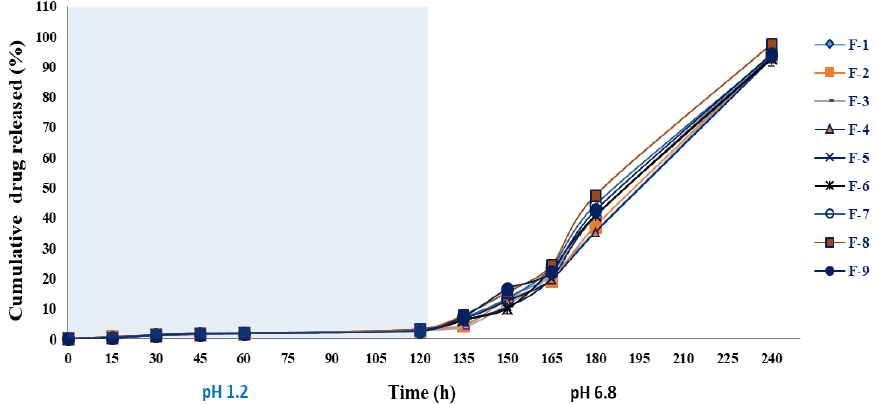
Figure 13. In vitro drug-release profile of alginate-BSO dry beads in simulated gastric fluid (pH 1.2) and simulated intestinal fluid (pH 6.8) (mean ± SD; n = 3).